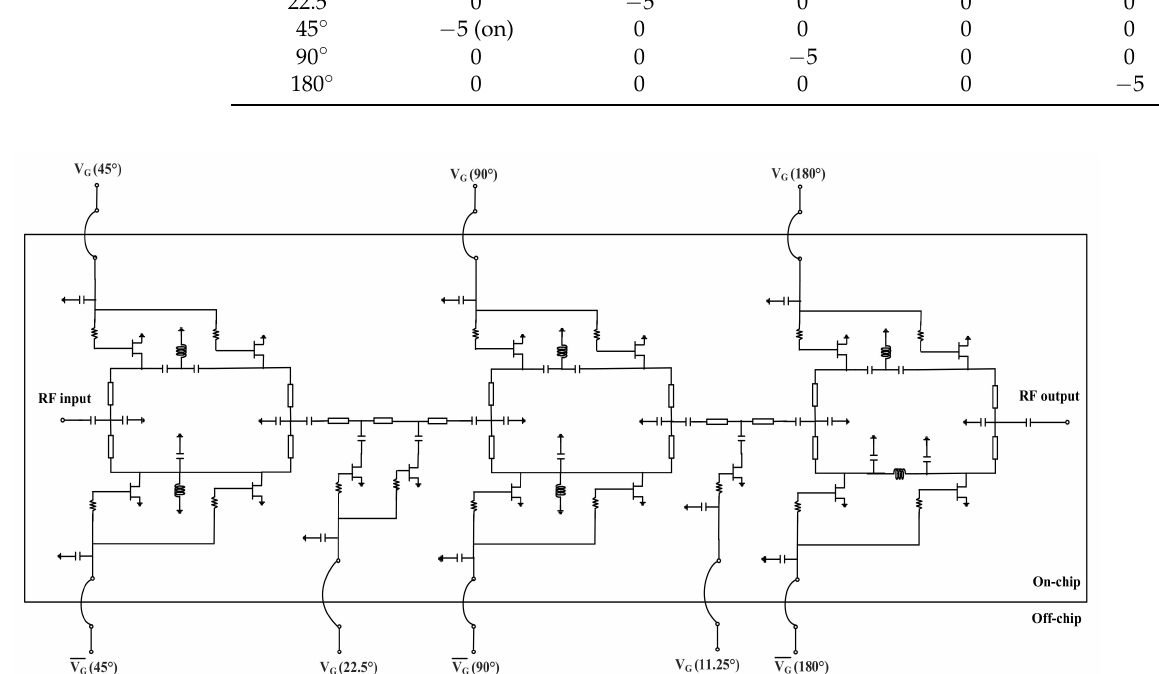
Figure 6. Complete schematic of the 5-bit X-band phase